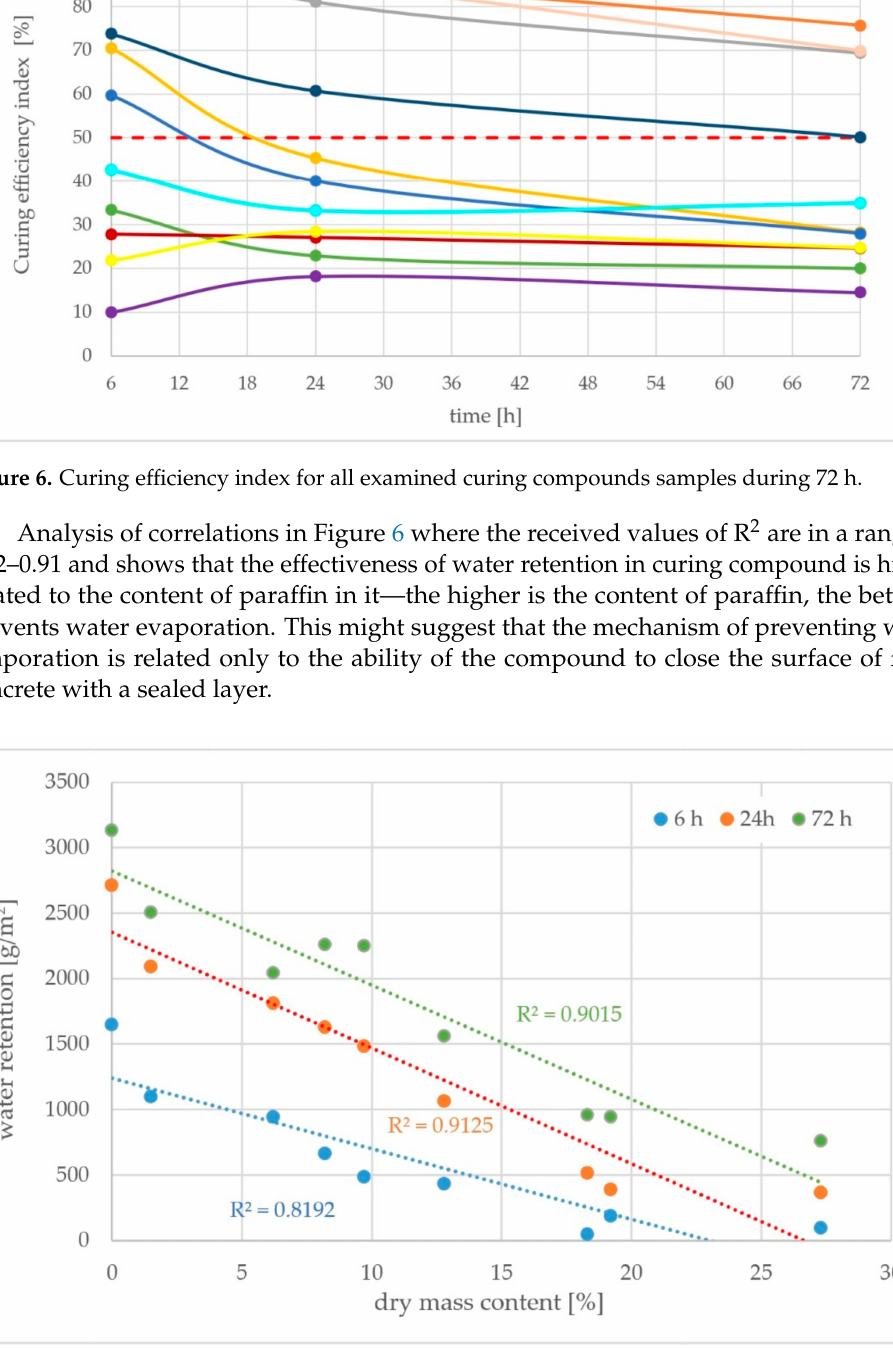
Figure 7. Correlation between water retention and dry mass for paraffin curing